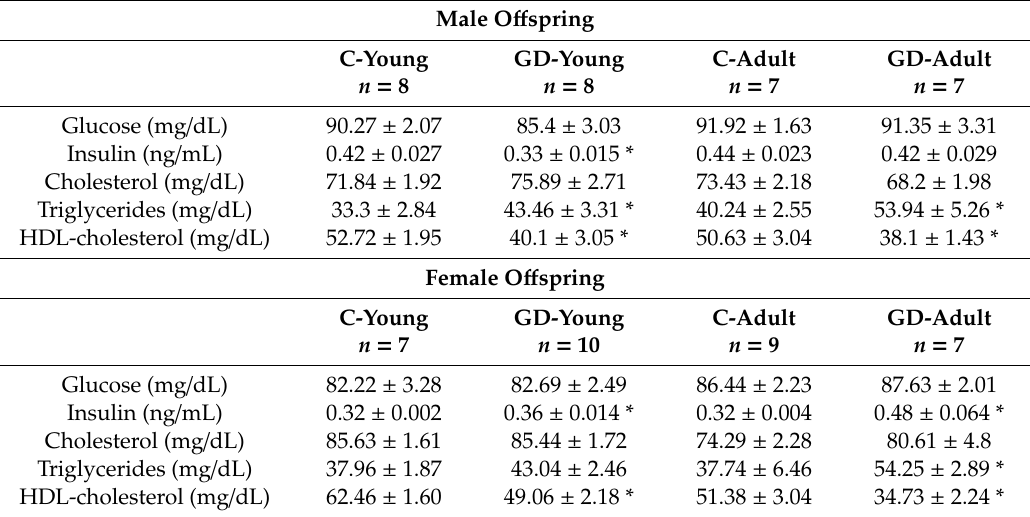
Table 4. Metabolic parameters of o ff